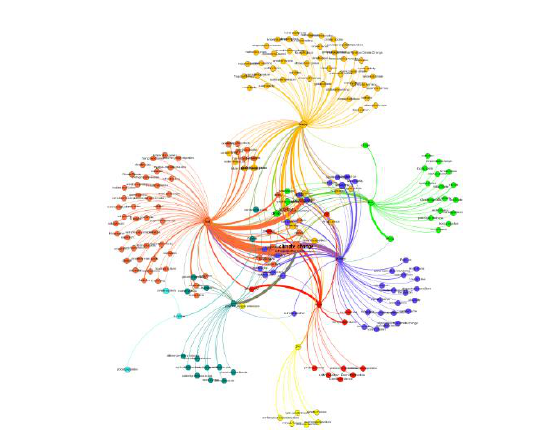
Figure 5 . Environmental terms and emotions network